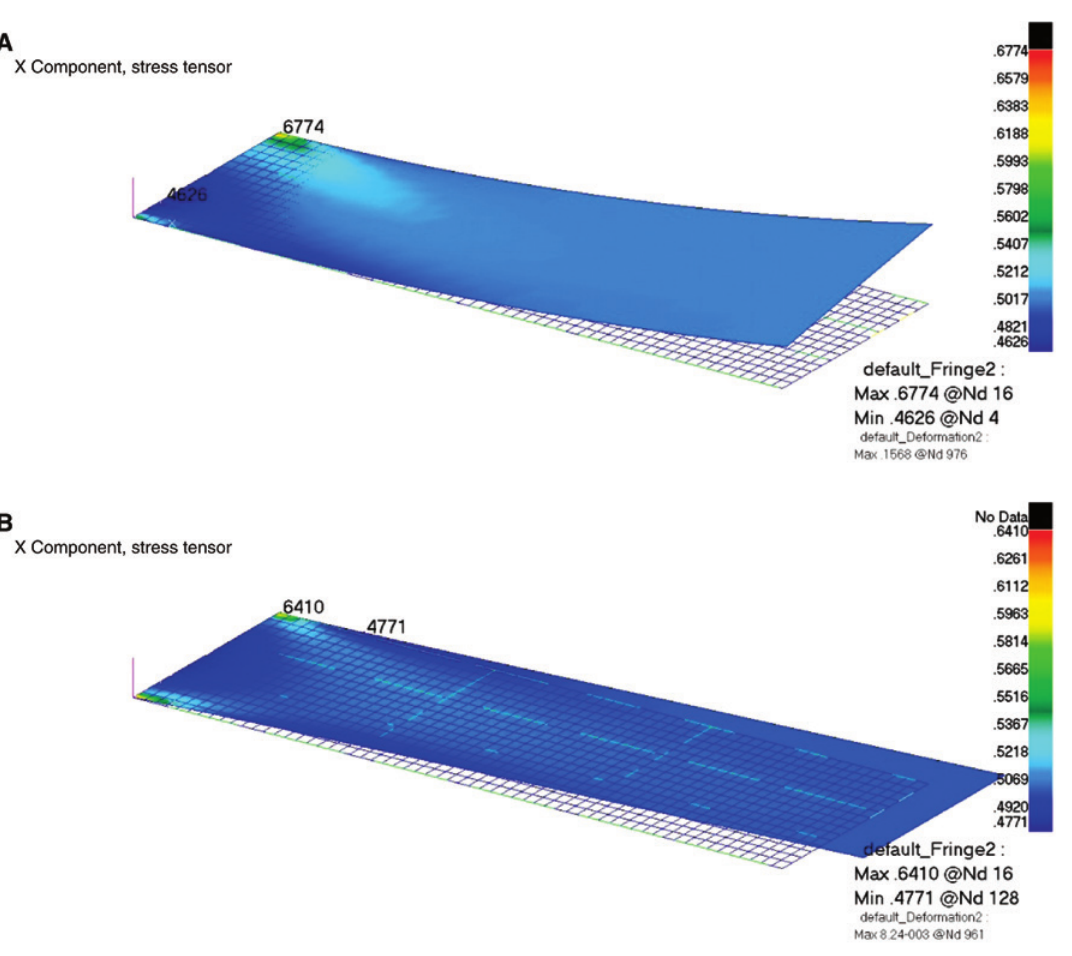
– total 16 repeats of (0/25) NCF, Load case: p Figure 12: Lay-up, (0/25) 16 T (A) Ply-by-ply analysis; (B) homogenized laminate analysis (displacements are not scaled).